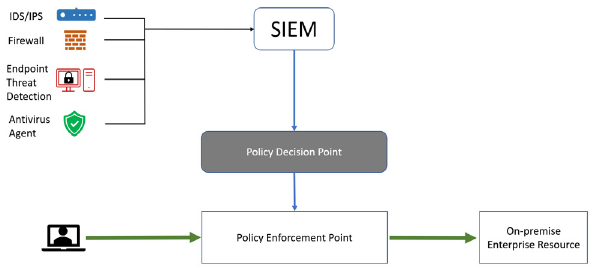
Figure 2. Policy evaluation process for On-premises infrastructure.